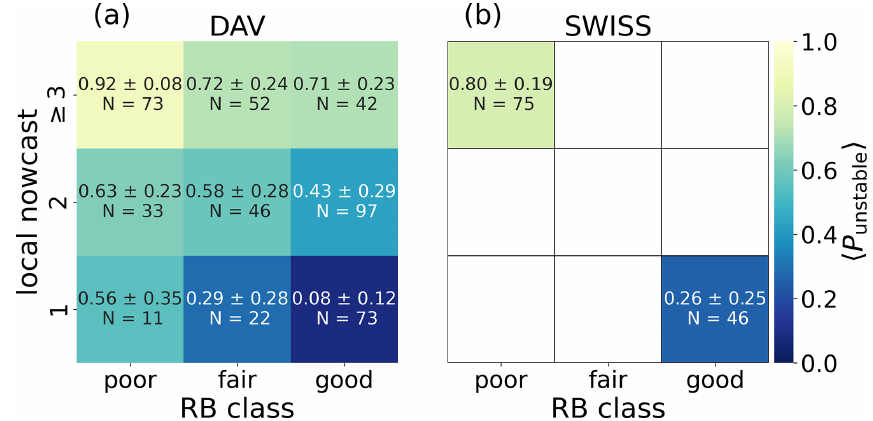
Figure 8. Average values (cid:104) P unstable (cid:105)± σ of the probability of instability over all manually determined weak layers shown for each RB–LN class of (a) the DAV data set and (b) the SWISS data set.